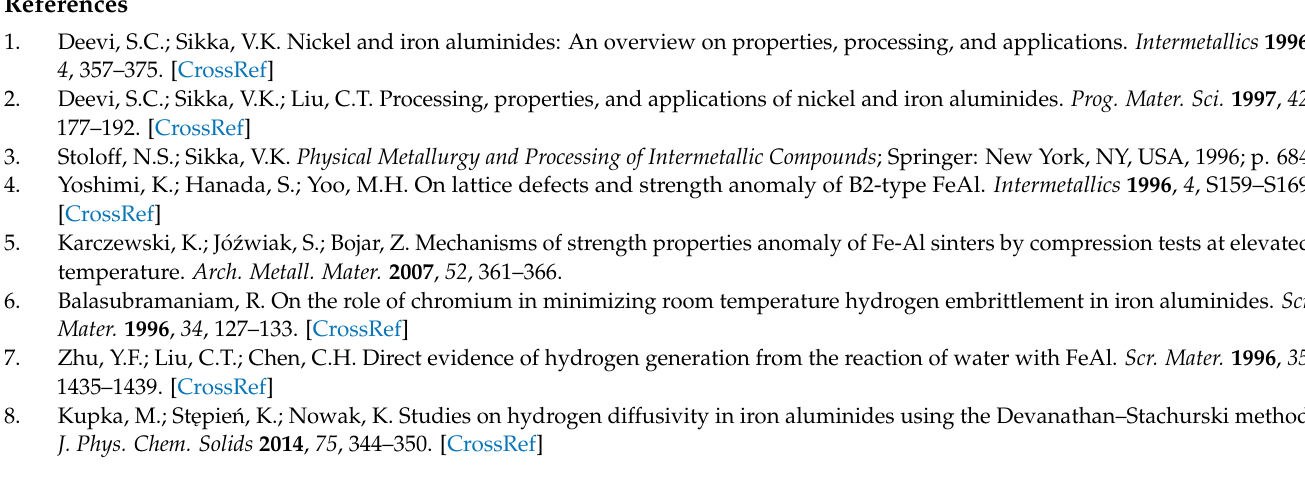
Figure A3. The scans of deformed shape of all samples.